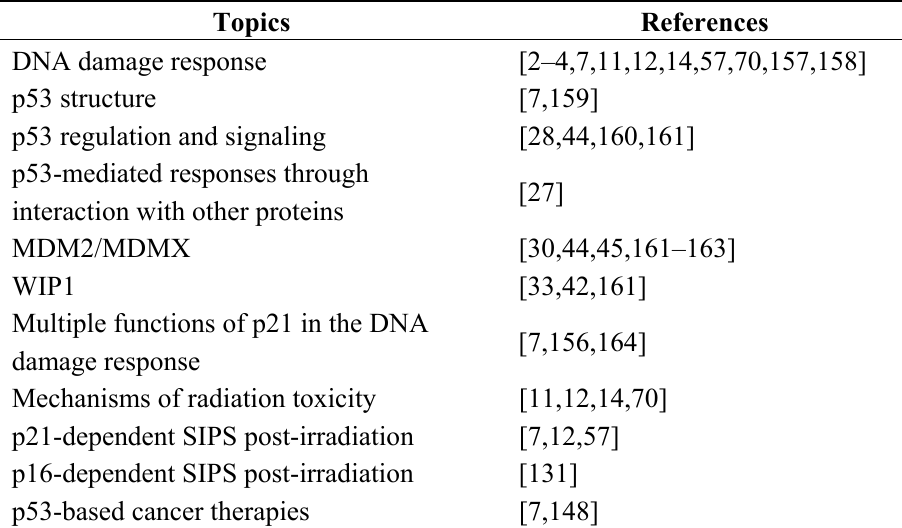
Table A1. Key review articles on the indicated